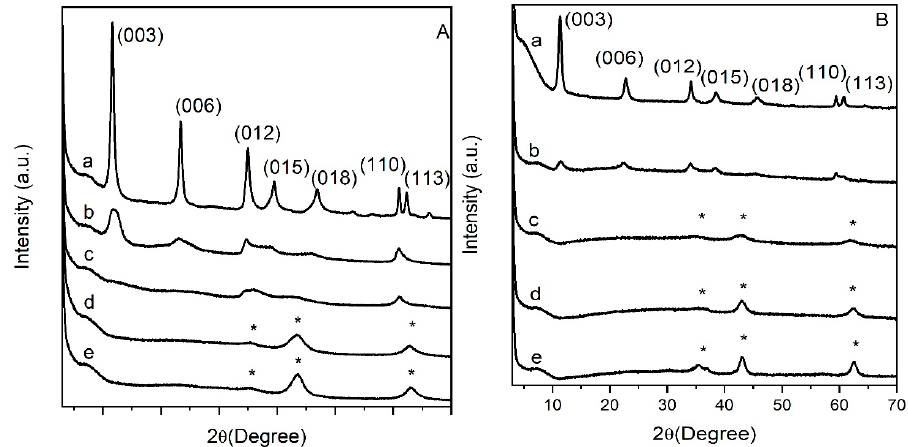
Figure 1. PXRD data of A: MgAl (a), MgAl calcined at: 200 °C (b), at 300 °C (c), at 400 °C (d) and at 500 °C (e); and B: MgFe ( a ), MgFe calcined at: 200 °C (b), at 300 °C (c), at 400 °C (d), and at 500 °C (e).